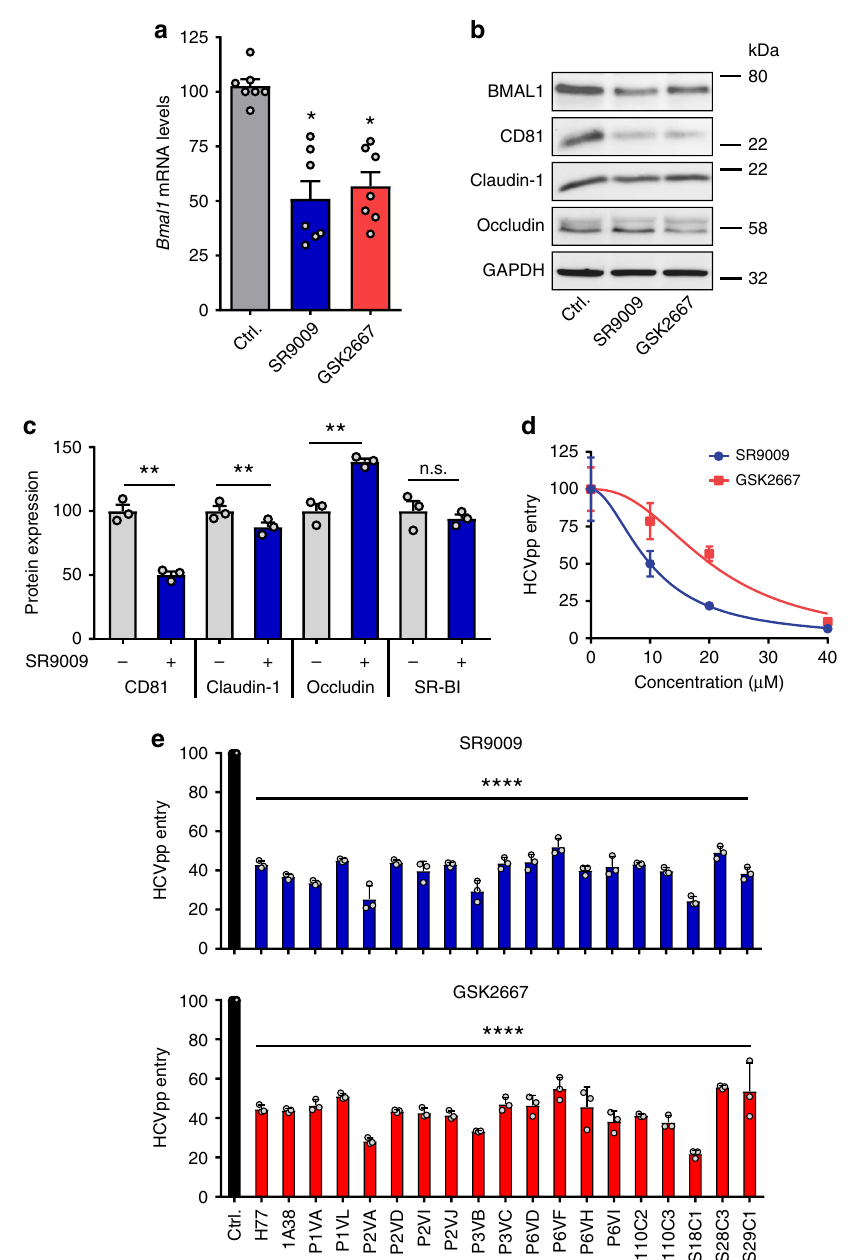
Fig. 2 REV-ERB agonists inhibit hepatitis C virus (HCV) entry. a REV-ERB agonists inhibit BMAL1 transcription. Huh-7 cells were treated with REV-ERB agonists SR9009 or GSK2667 (20 µ M) for 24 h and Bmal1 mRNA levels quanti fi ed by qRT-PCR, respectively (mean± S.E.M., n = 7, Kruskal – Wallis ANOVA with Dunn ’ s test). b , c REV-ERB agonists modulate HCV receptor expression. Huh-7 cells were treated with the REV-ERB agonists SR9009 or GSK2667 (20 µ M) for 24 h and the cells lysed, total protein measured and assessed for CD81, claudin-1 and occludin expression together with the housekeeping GAPDH by western blotting or mass spectrometric analysis (mean ± S.E.M., n = 3, Mann – Whitney test). d REV-ERB agonists inhibit HCV entry. Huh-7 cells were treated with increasing dose of REV-ERB agonists SR9009 or GSK2667 for 24 h, inoculated with HCVpp and infection assessed 24 h later (mean ± S. E.M., n = 5). e REV-ERB agonists inhibit HCVpp bearing patient-derived glycoproteins. Huh-7 cells were treated with the REV-ERB agonists SR9009 or GSK2667 (20 µ M) for 24 h, infected with HCVpp bearing patient-derived envelope glycoproteins and infection assessed 24 h later. In all cases, data are expressed relative to untreated (Ctrl) cells. (Mean ± S.E.M., n = 3, Kruskal – Wallis